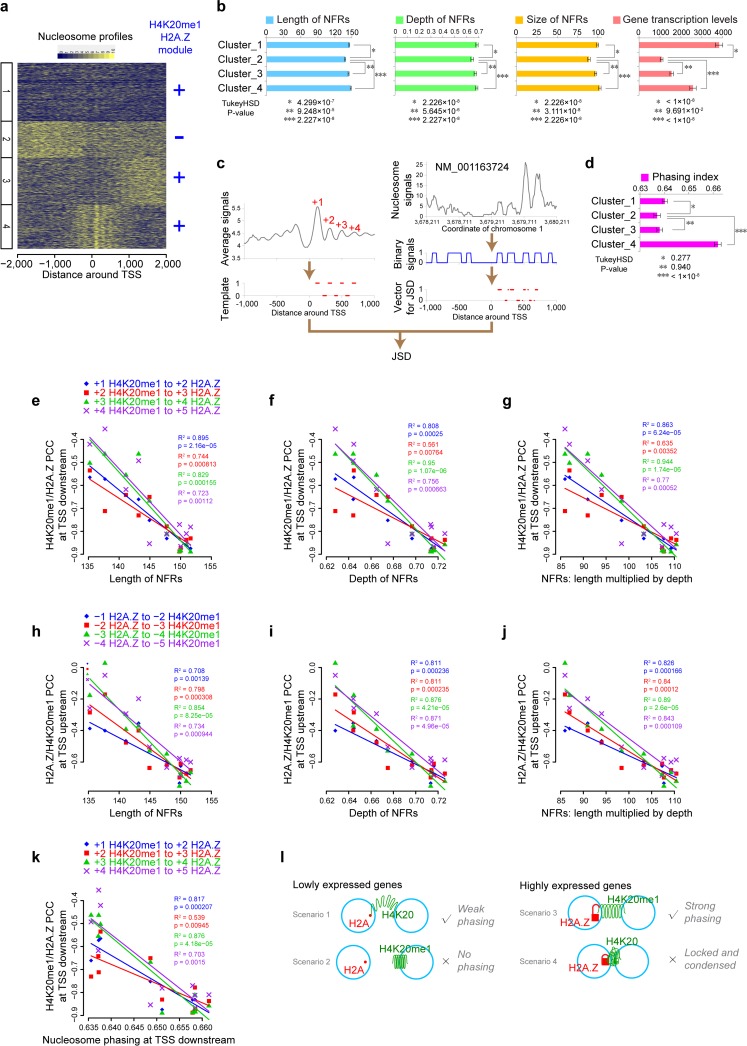
Association of the H4K20me1-H2A.Z interaction with nucleosome profile patterns around TSS.(a) Four clusters of the nucleosome profiles in -2000 ~ +2000 bp regions surrounding TSS. The H4K20me1-H2A.Z interaction was obtained in Cluster 1, 3 and 4. (b) Length, depth and size of nucleosome free regions, and gene transcription levels for each of the four TSS clusters. The mean and standard error of the mean (SEM) are shown. One-way ANOVA was used for overall comparison, and TukeyHSD test was used to calculate the p-values between Cluster 2 and other clusters. (c) Pipeline for calculating Nucleosome Phasing Index. Nucleosome Phasing Index was quantified based on the Jensen-Shannon divergence distance (JSD) between the binary template vector and the binary-converted nucleosome-signal vector of each TSS (see Methods for details). (d) Phasing Index for each of the four TSS clusters. Statistical tests were same as (b). (e-g) Cross-group linear regression for H4K20me1-H2A.Z anti-correlation versus the NFR length (e), depth (f), and size (length × depth) (g) downstream of TSSs, respectively. Adjusted R2 and p-values are labeled on the panels. (h-j) Same as (e-g), but for the H2A.Z-H4K20me1 anti-correlation at TSS upstream. (k) Cross-group linear regression for H4K20me1-H2A.Z anti-correlation versus nucleosome Phasing Index. (l) Mechanistic model of the H2A.Z-H4K20me1 inter-nucleosome interaction. For lowly expressed genes, neither H2A.Z or H4K20me1 is present (Scenario 1), where H2A and H4K20 from neighboring nucleosome can weakly interact to form a weak interaction between nucleosomes and phasing around TSS through the weak acidic patch of H2A; If there exist H4K20me1 (Scenario 2), it would disrupt inter-nucleosome interaction, cause loss of phasing, and expose DNA to spurious transcription, which is an unfavorable situation. For highly expressed genes, the presence of both H2A.Z and H4K20me1 (Scenario 3) will make a flexible and controllable strong interaction between H4K20me1 of the neighboring nucleosome through the strong acidic patch of H2A.Z; Alternatively, if H4K20 is not methylated (Scenario 4), the interaction is too strong to be regulated and has a propensity to form condensed chromatin structure. The strong extended H2A.Z acidic patch is represented by a lock.